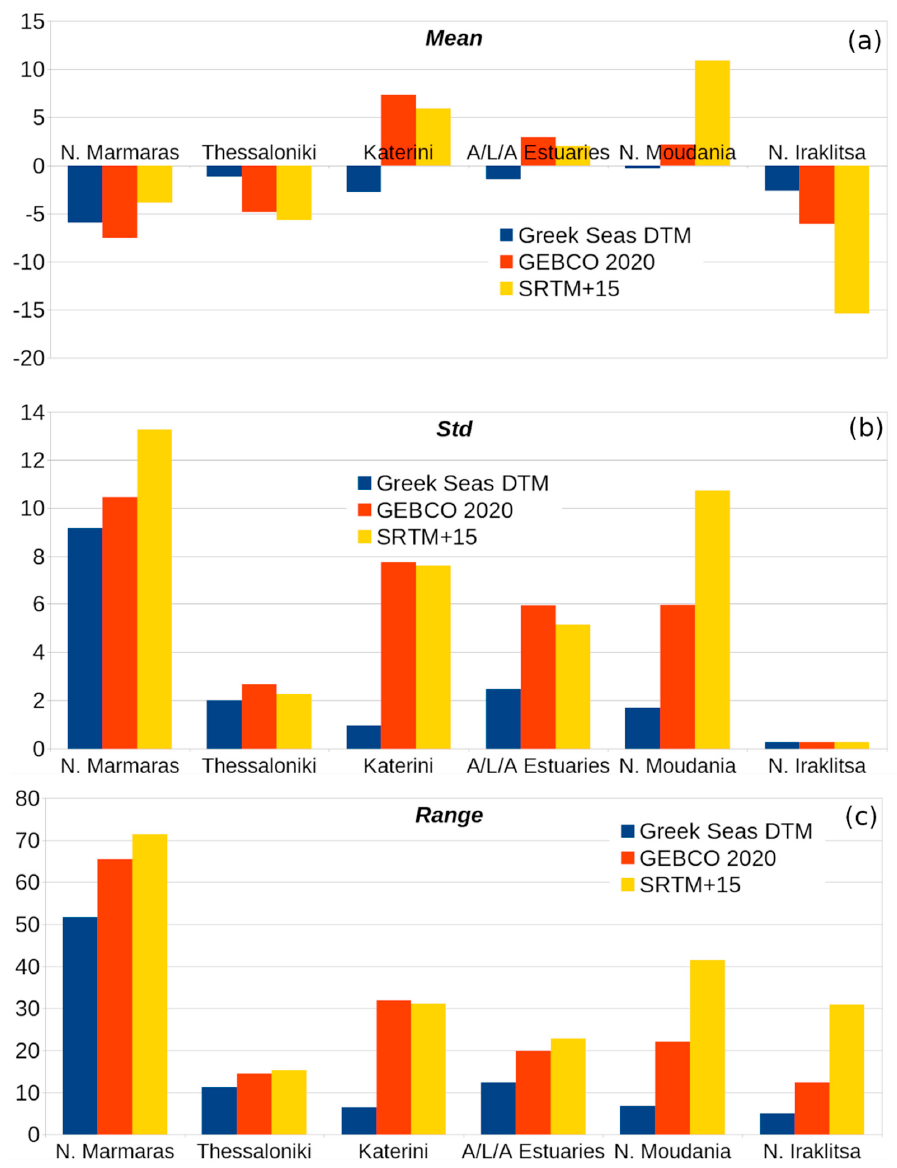
Figure 9. Statistics of the differences between the models and in situ depth measurements per area: ( a ) mean value, ( b ) standard deviation, and ( c ) range. ( x ‐ axis: area/ y ‐ axis: m).